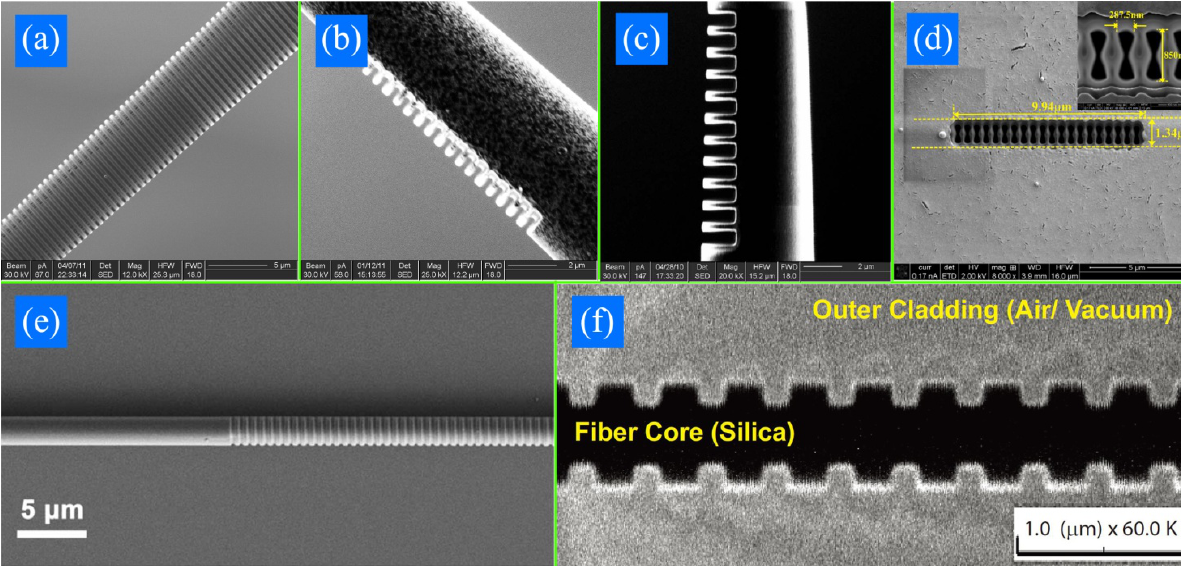
Figure 2. FIB/SEM pictures of gratings fabricated on MF tips ( a ) [31], ( b ) [32], ( c ) [35] and MF tapers ( d ) [34], ( e ) [36], ( f ) [37]. Reprinted with permission. Copyright 2011 Optical Society of America and Copyright 2011